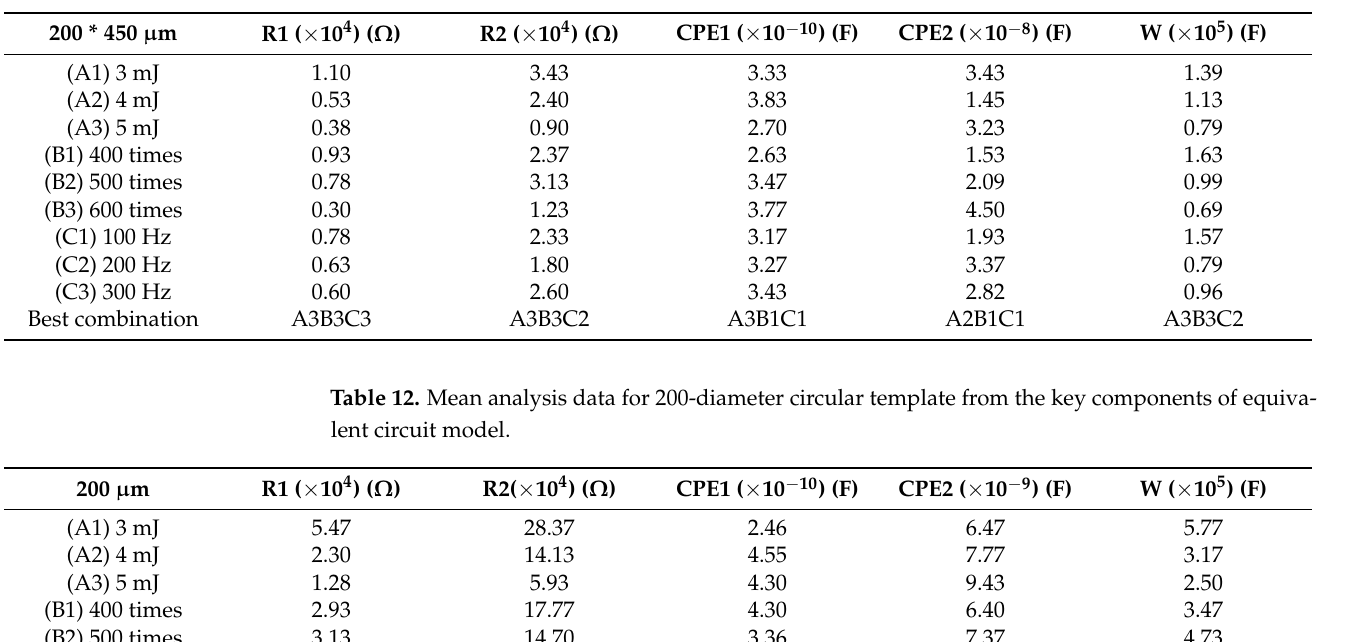
Table 11. Mean analysis data for 200 * 450 µ m rectangular template from the key components of equivalent circuit model.